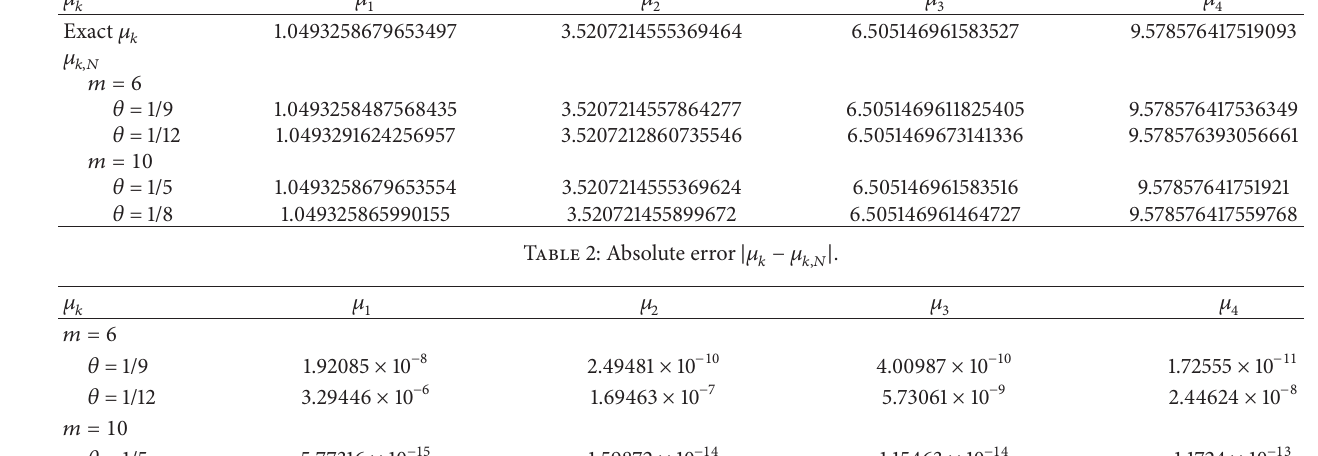
Table 1: With 𝑁 = 15 , the approximation 𝜇 𝑘,𝑁 and the exact solution 𝜇 𝑘 for different choices of 𝑚 and 𝜃 .